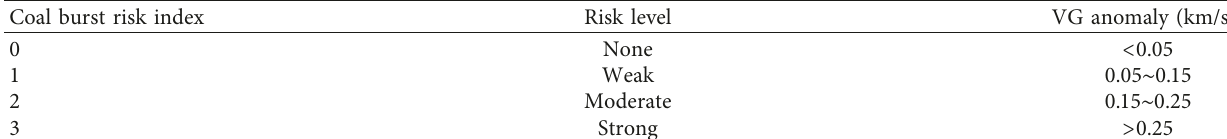
Table 4: Relation between the VG value and the coal burst hazard level.